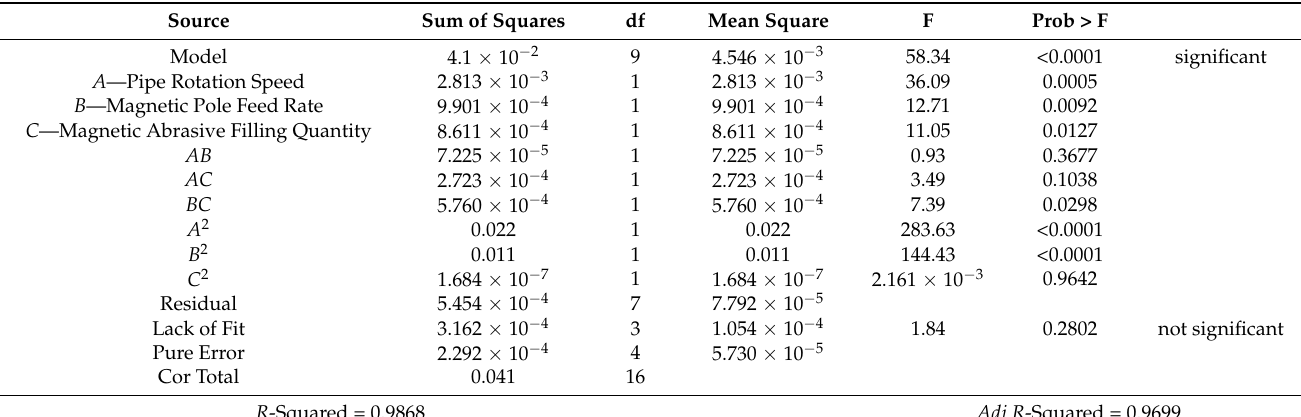
Table 6. ANOVA results of surface